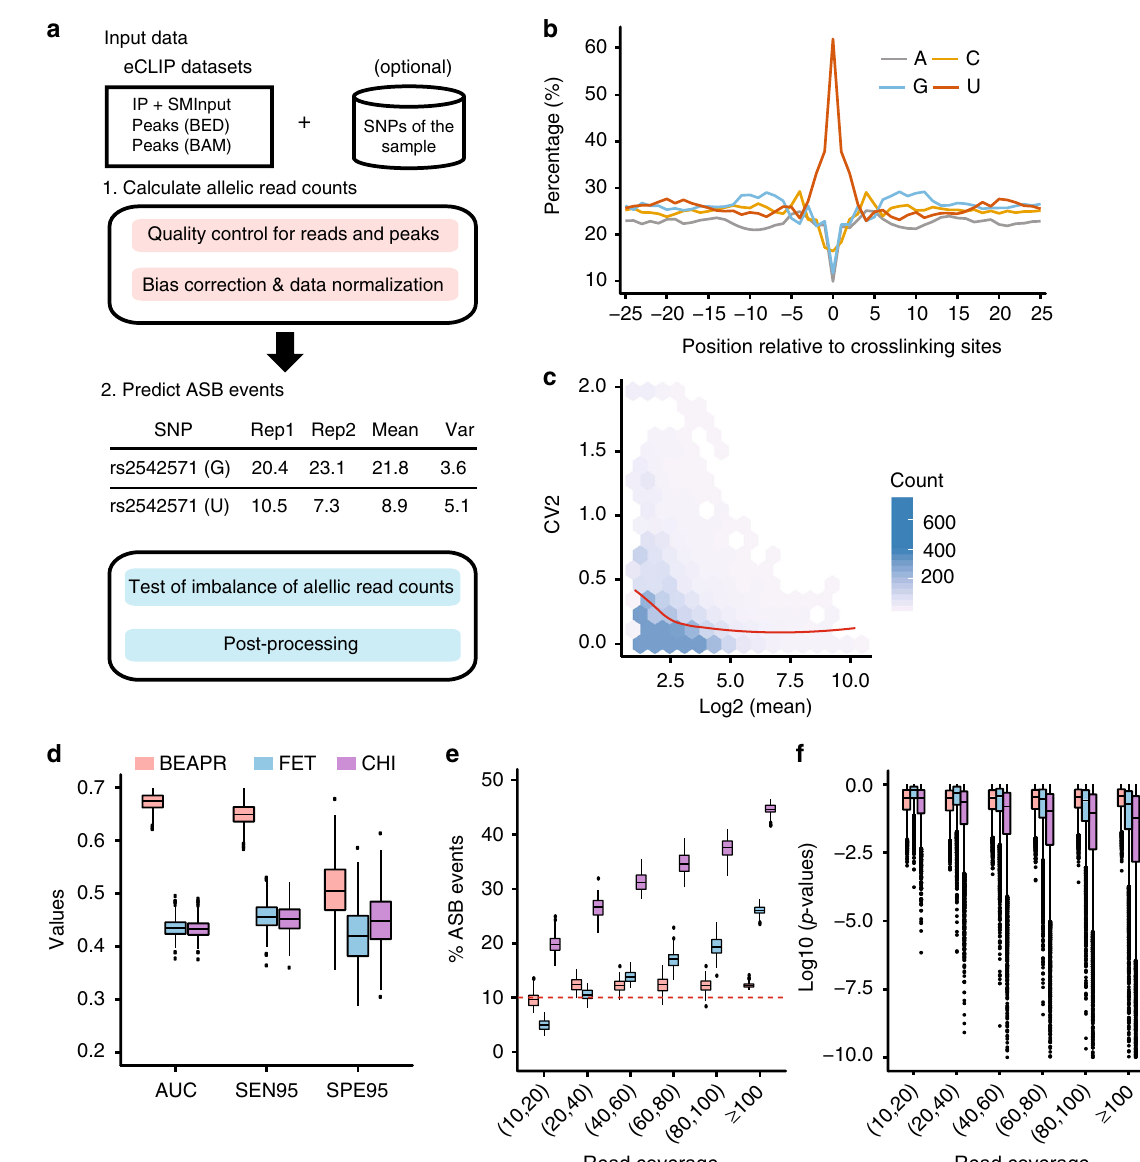
Fig. 1 Overview of BEAPR (Binding Estimation of Allele-speci fi c Protein – RNA interaction) and its performance. a Overall work fl ow of BEAPR. See Methods for details. b Crosslinking-induced bias in the SMInput sample of RBFOX2 (HepG2 cells). Y -axis shows the relative % of each nucleotide observed at each position relative to the crosslinking site ( x = 0). c The square of the coef fi cient of variation (CV2) plotted as a function of the observed allelic read counts (mean of the two replicates) in the RBFOX2 enhanced crosslinking and immunoprecipitation (eCLIP) data in HepG2 cells (see Methods). d Performance comparison of three methods using simulated data (with simulated crosslinking-induced biases) and true allelic ratio of 0.8 for allele-speci fi c binding (ASB). Data derived from 1000 simulation experiments each encompassing 5000 single-nucleotide variants (SNVs) (10% of which being ASB). FET: Fisher ’ s exact test; CHI: χ 2 test; AUC: area under the curve of the precision-recall curve. SEN95: sensitivity at 95% speci fi city; SPE95: speci fi city at 95% sensitivity. e Percentage of ASB events among all tested SNVs by the three methods using simulated data as in d . The x -axis shows different read coverage bins (using average read coverage of each SNV in two simulated replicates). The red dashed line corresponds to the 10% value, that is, the percentage of true ASB events in the simulation. f Box plots of p values calculated by the three methods at different levels of read coverage. Boxplot center lines indicate the median and the boxes extend to lower and upper quartiles with whiskers depicting 1.5 interquartile range (IQR). The discrete points are the outliers. (Source data are provided as a Source Data fi